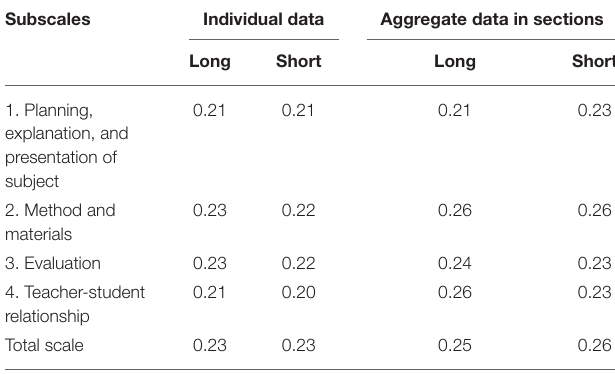
TABLE 5 | Correlations between the long and short versions of the scale of evaluation of teaching with academic performance, taking individual, and aggregate data in